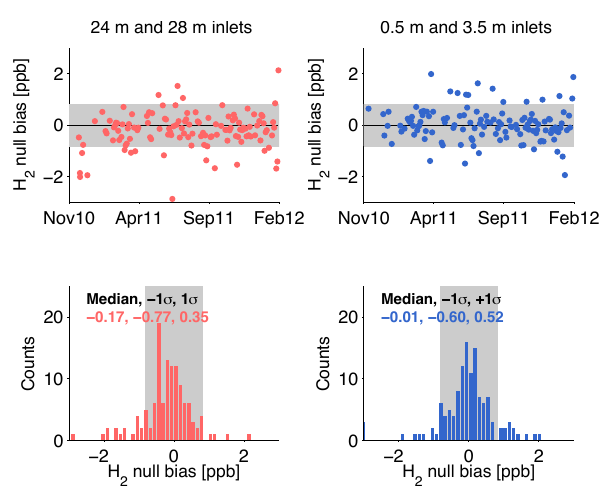
Figure 5. Time series (upper plots) and distributions (lower plots) of the measurement 370 bias between sampling lines for the 24 m and 28 m (left plots) and the 0.5 m and 3.5 m 371 (right plots) H 2 measurements as determined by the nulling procedure. The median and 372 the 1 σ confidence intervals are reported for each distribution and are compared with 373 minimum detectable difference given the median instrument 1 σ precision (grey shading). 374 The nulling procedure was a valuable tool to diagnose bias to between sampling 376 lines, though in retrospect mixing the reservoir, increasing its volume, using multiple 377 reservoirs in series, or filling the reservoir from a level with less variability (i.e., farther 378